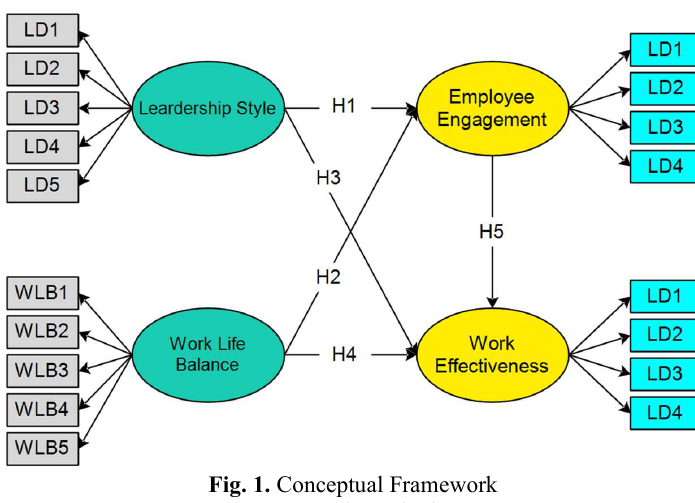
Fig. 1. Conceptual Framework Research